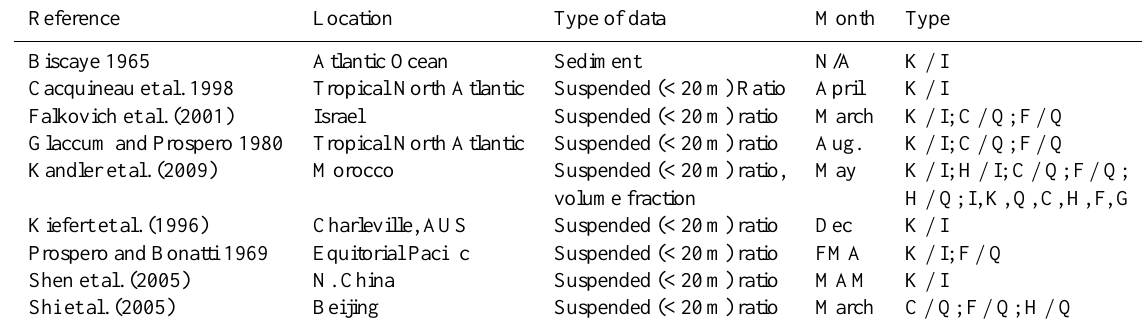
Table 5. Observations of mineralogy used to evaluate simulated mineral distributions in CAM4 and CAM5. Near-surface observational data were chosen in order to compare to near-surface mineral concentrations in the models. Ocean core sediment data are compared to bulk dry and wet